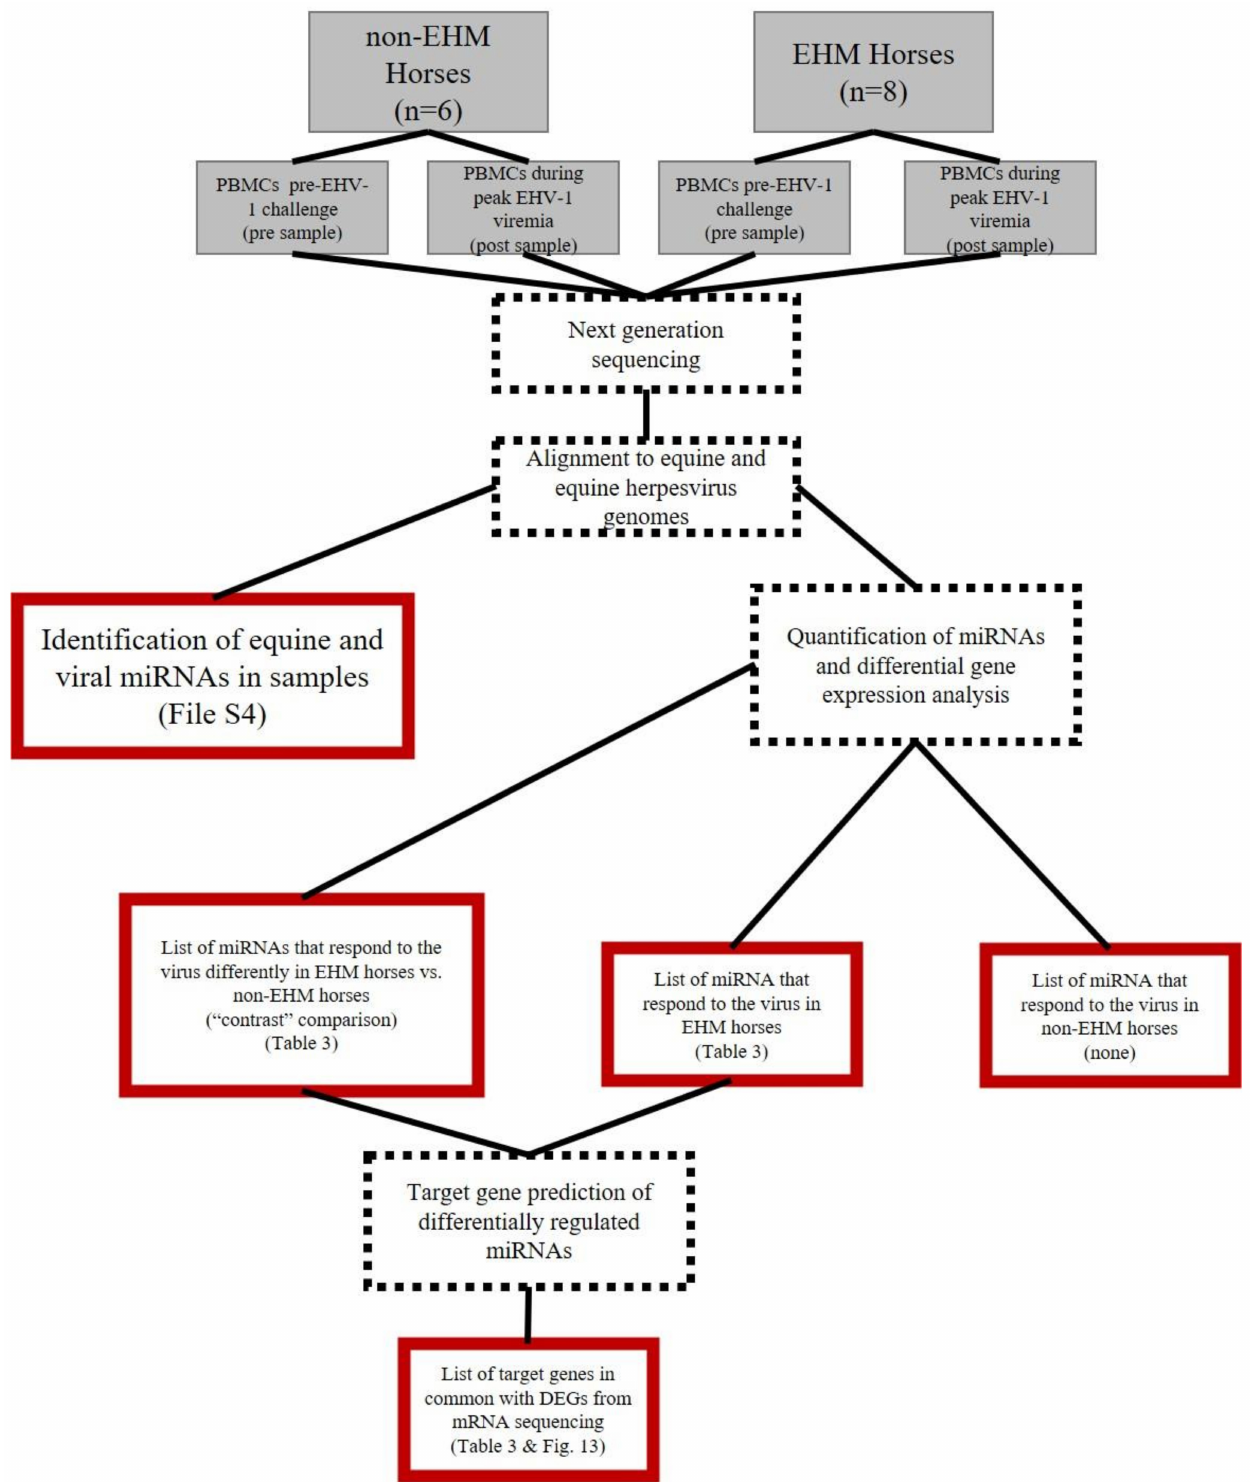
Figure 2. Summary of miRNA sequencing data analysis. RNA was extracted from PBMCs from horses prior to and during EHV-1 CH. The gray boxes represent experimental design. The dashed outline boxes are data analysis processes (actions). Black and red boxes represent output. The red outline indicates final output used for